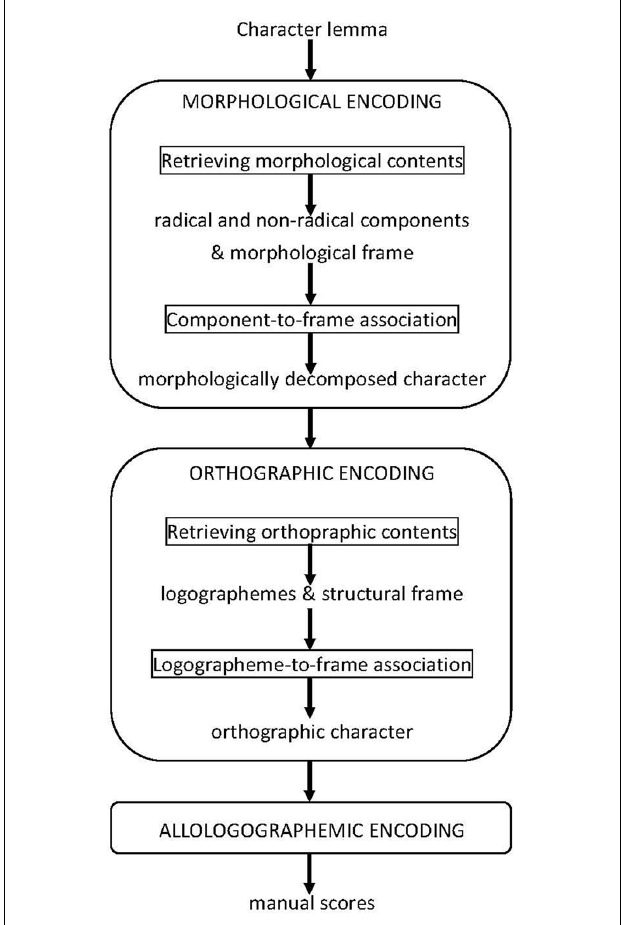
FIGURE 1 | A tentative model of Chinese handwritten character